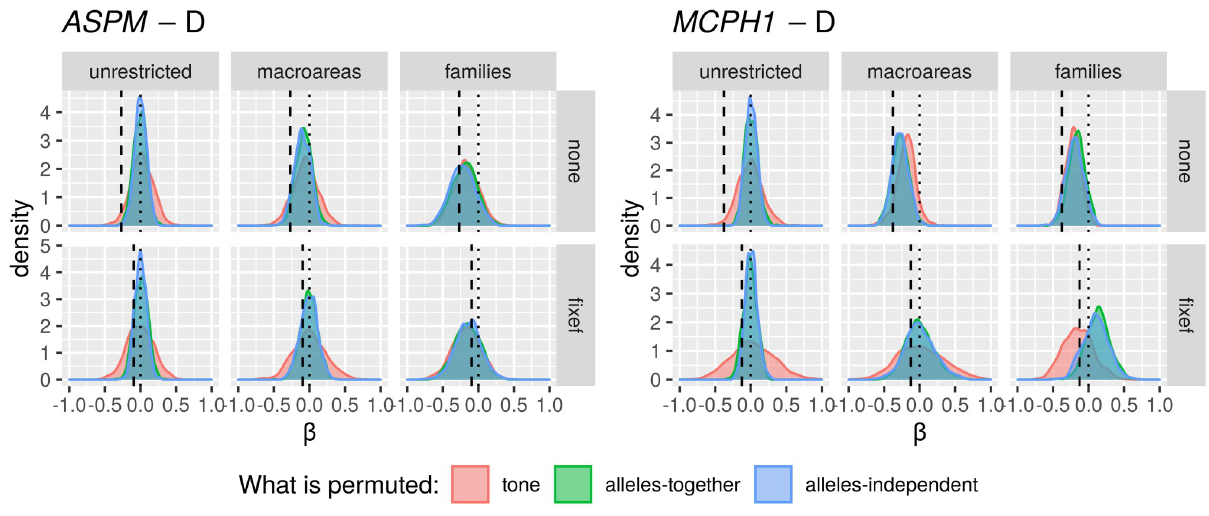
Fig 26. Distribution of the permutation regressions for tone counts . Same conventions as in Fig 9.